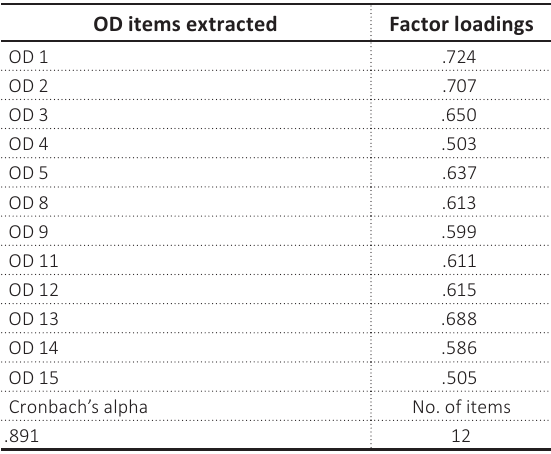
Figure 3. Work Table 2. Factor: Organizational Decision (OD)